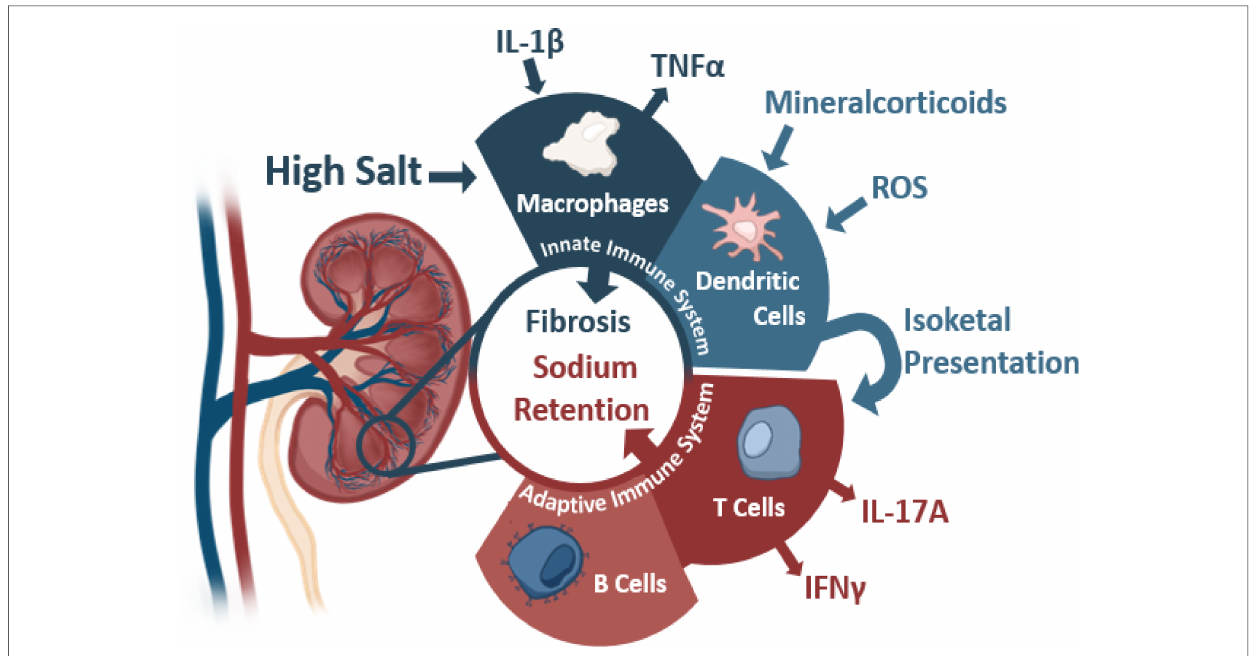
FIGURE 1 The contributions of the innate and adaptive immunity to kidney damage during hypertension with various activating stimuli and subsequent cytokine production. Sources below: Macrophages: IL-1 β (Veiras et al., 2022, Circulation Research, secondary hypertension), TNF α (Singh et al., 2013 American Journal of Physiology: Renal Physiology, essential hypertension). Dendritic Cells: Mineralcorticoids (Araos et al., 2019 Journal of Hypertension, secondary hypertension), ROS (Lu et al., 2020 Hypertension, essential hypertension), and Isoketals (Kirabo et al., 2014, Journal of Hypertension, essential hypertension). T Cells: IL-17 (Kamat et al., 2015, Hypertension, essential hypertension), IFN γ (Benson et al., 2022 Circulation Research and Kamat et al., 2015, Hypertension, essential hypertension). B Cells: (Chan et al., 2015 Hypertension